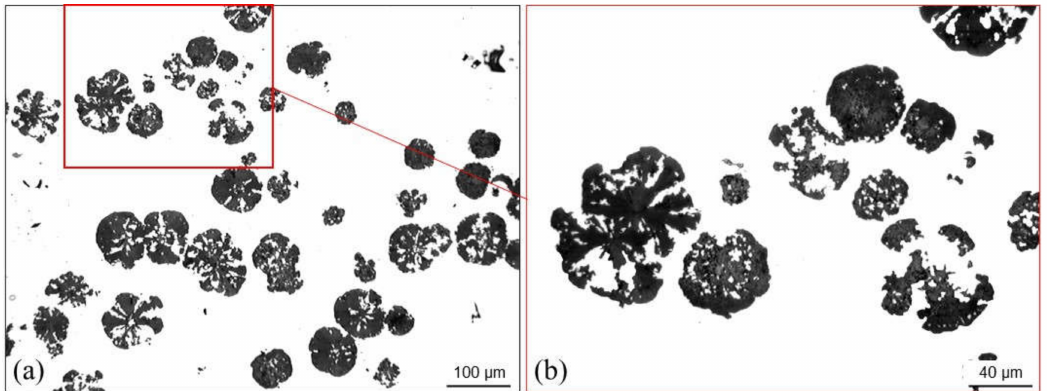
Figure 78. Optical micrographs showing exploded graphite particles in the top area of a massive ductile iron casting: general view ( a ) and detailed view ( b